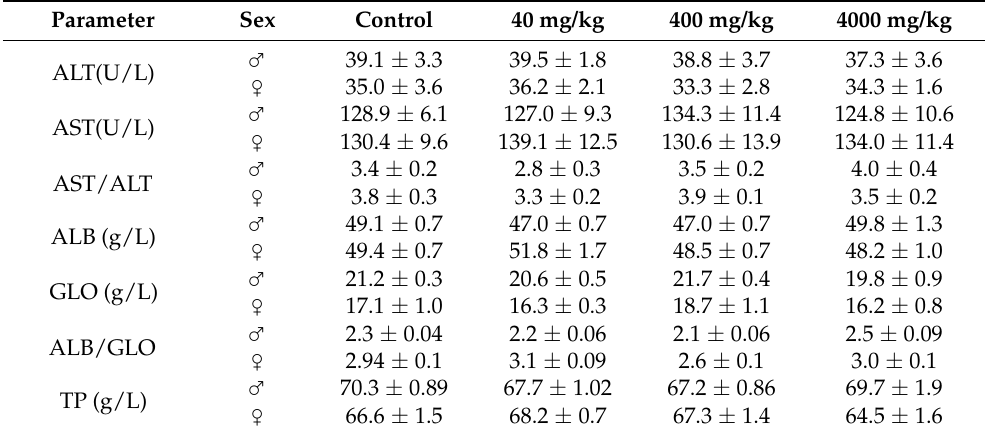
Figure 2. Effect of HTE (40, 400 and 4000 mg/kg) on the renal serum biochemical parameters in the subacute administration study. All data are presented as the mean ± SEM ( n = 10). ( a ) The blood urea nitrogen (BUN) levels of female mice. ( b ) The creatinine (CREA) levels of female mice. ( c ) The BUN/CREA levels of female mice. ( d ) The uric acid levels of female mice. ( e ) The BUN levels of male mice. ( f ) The CREA levels of male mice. ( g ) The BUN/CREA levels of male mice. ( h ) The uric acid levels of male mice. Statistical significance was analyzed by using the Student’s t -test. Compared with the control, * and *** represent 0.01 < p < 0.05 and p < 0.001, respectively. Table 3. The serum biochemical parameters, blood glucose and triglyceride of HTE (40, 400 and 4000 mg/kg) at the end of subacute toxicity study.